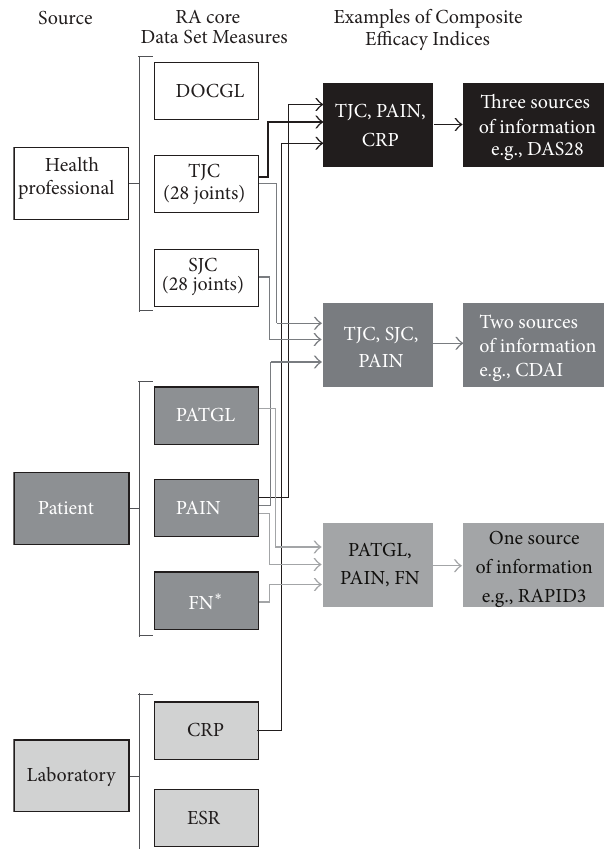
Figure 1: Combinations of RA Core Data Set measures used to derive Composite Efficacy Indices. ∗ Measured using the Health Assessment Questionnaire. For comparison, DAS28, CDAI, and RAPID3 are derived using different formulae. DAS28 includes 4 RA Core Data Set measures (TJC, SJC, CRP (or ESR), and PATGL) from three sources. CDAI includes four RA Core Data Set measures (TJC, SJC, DOCGL, and PATGL) from two sources. RAPID3 includes three RA Core Data Set measures (PATGL, PAIN, and FN) from one source. CDAI: Clinical Disease Activity Index; CRP: C-reactive protein; DAS28: Disease Activity Score in 28 joints; DOCGL: assessor global; ESR: erythrocyte sedimentation rate; FN: physical function; PAIN: pain; PATGL: patient global estimate; RAPID3: Routine Assessment of Patient Index Data 3; SJC: swollen joint count; TJC: tender joint